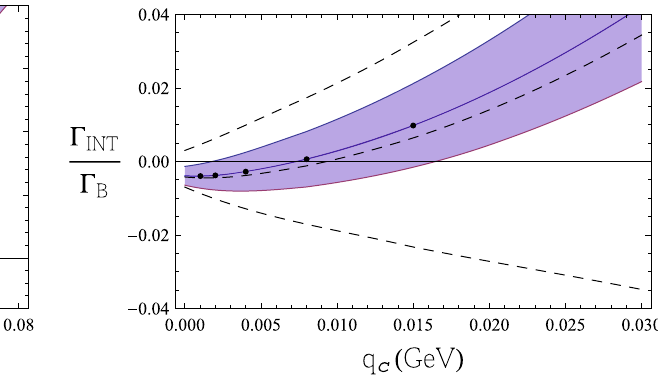
Fig. 2 Interference term normalized to the Bremstrahlung rate for dif- ferent lower cuts in q . The points correspond to the (inverse) values showninTable2.Thebandinbluecorrespondstothe1sigmalevelshift of the different counterterms. The dotted lines correspond to switching